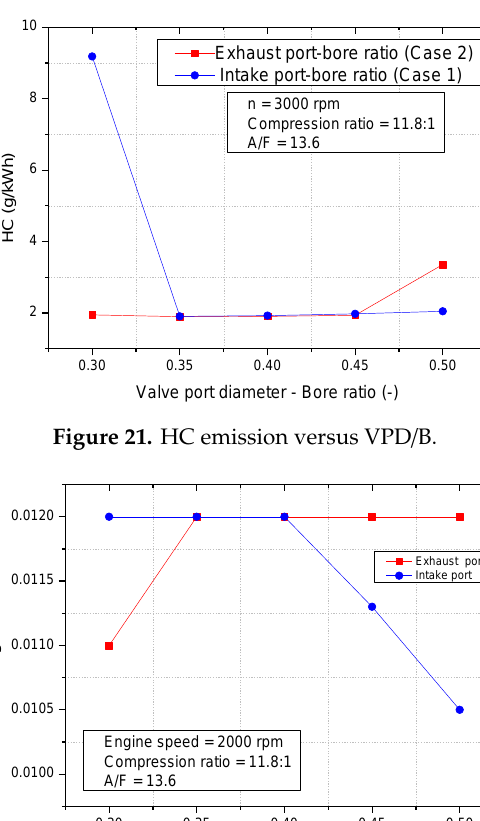
Figure 20. NO x emission versus VPD / B.